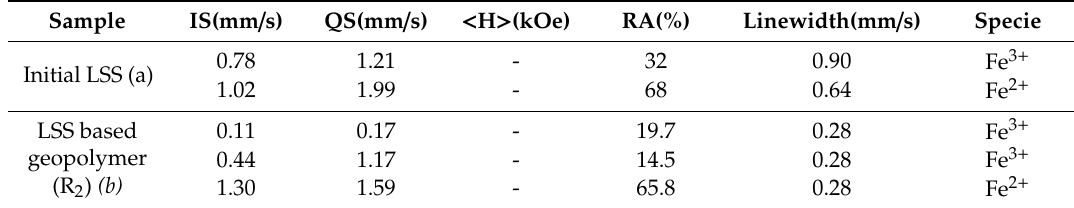
Table 3. Mössbauer parameters of the initial LSS (a) and LSS based geopolymer (R 2 ) after being hydrated for 28